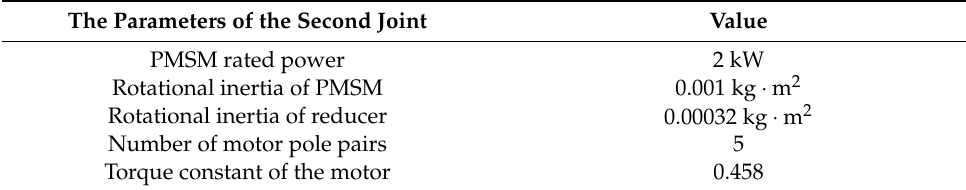
Figure 16. Six-degree-of-freedom industrial robots. Table 3. Test bench parameters. Table 3. Test bench parameters.